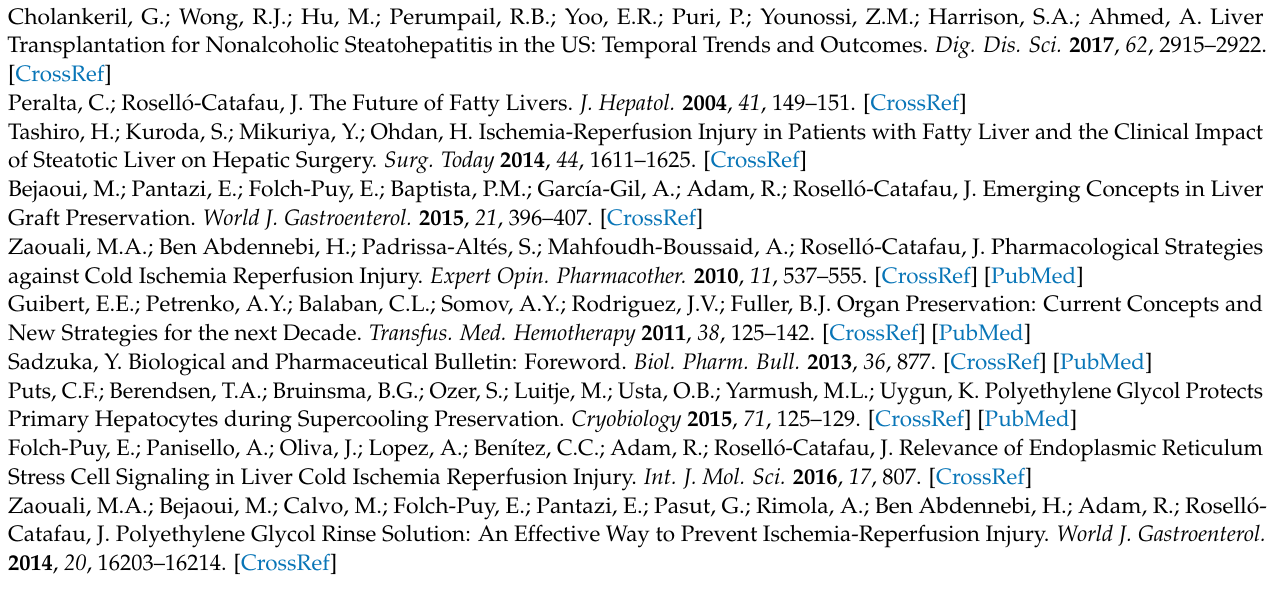
Figure S4: Membranes and loading control (Figure